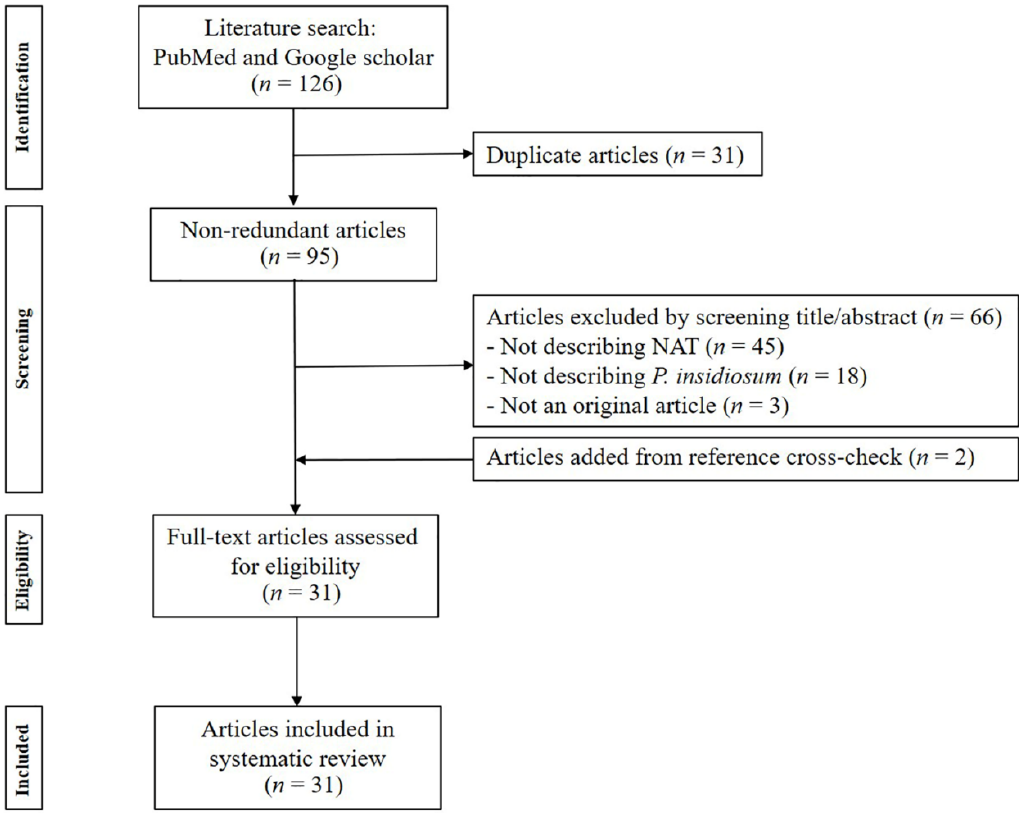
Figure 1. PRISMA-based flow chart demonstrating the article-procurement